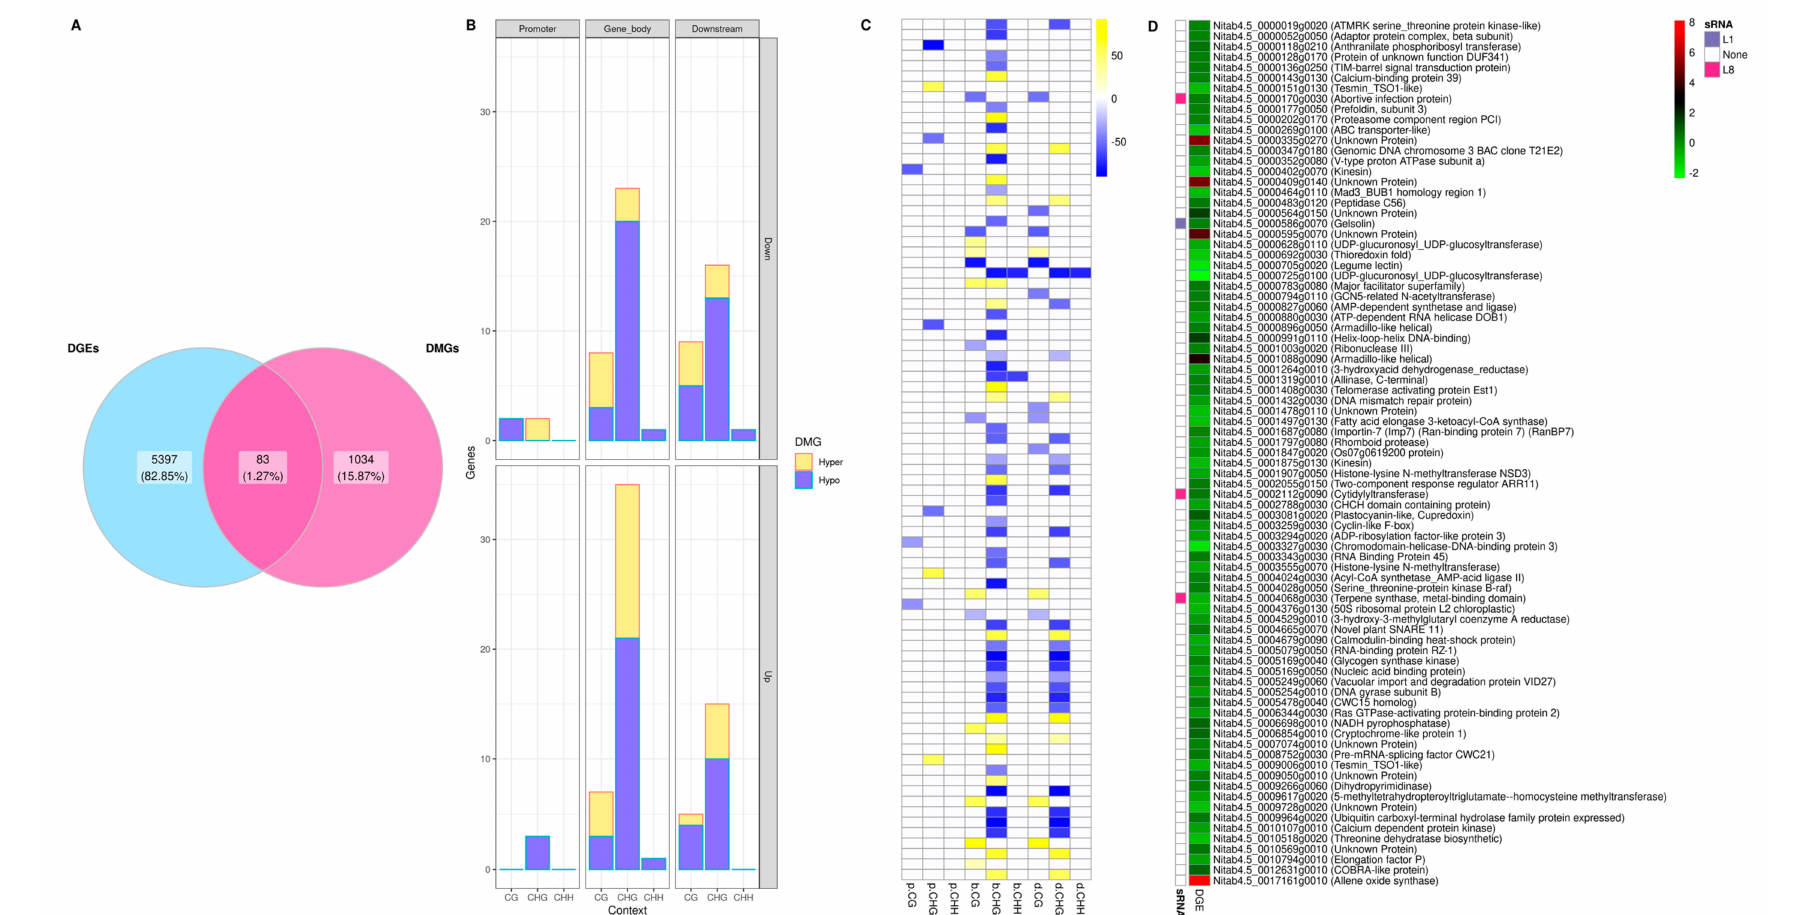
Figure 5. Correlation of differential methylation and differential gene expression in transgenic tobacco associated with the H 2 O 2 response. ( A ) Number of DMCs associated with DEGs. ( B ) DMCs profiles of the up/down-regulated genes in different sequence contexts and gene regions. Scale color represents methylation level difference (blue = hypomethylation; yellow = hypermethylation). ( C ) DmCs profiles of up/down-regulated genes involved in H 2 O 2 response in tobacco. ( D ) Gene expression profiles (L8/L1) of the genes with DmCs. Scale color represents log2 fold-change expression (red = upregulation, green =